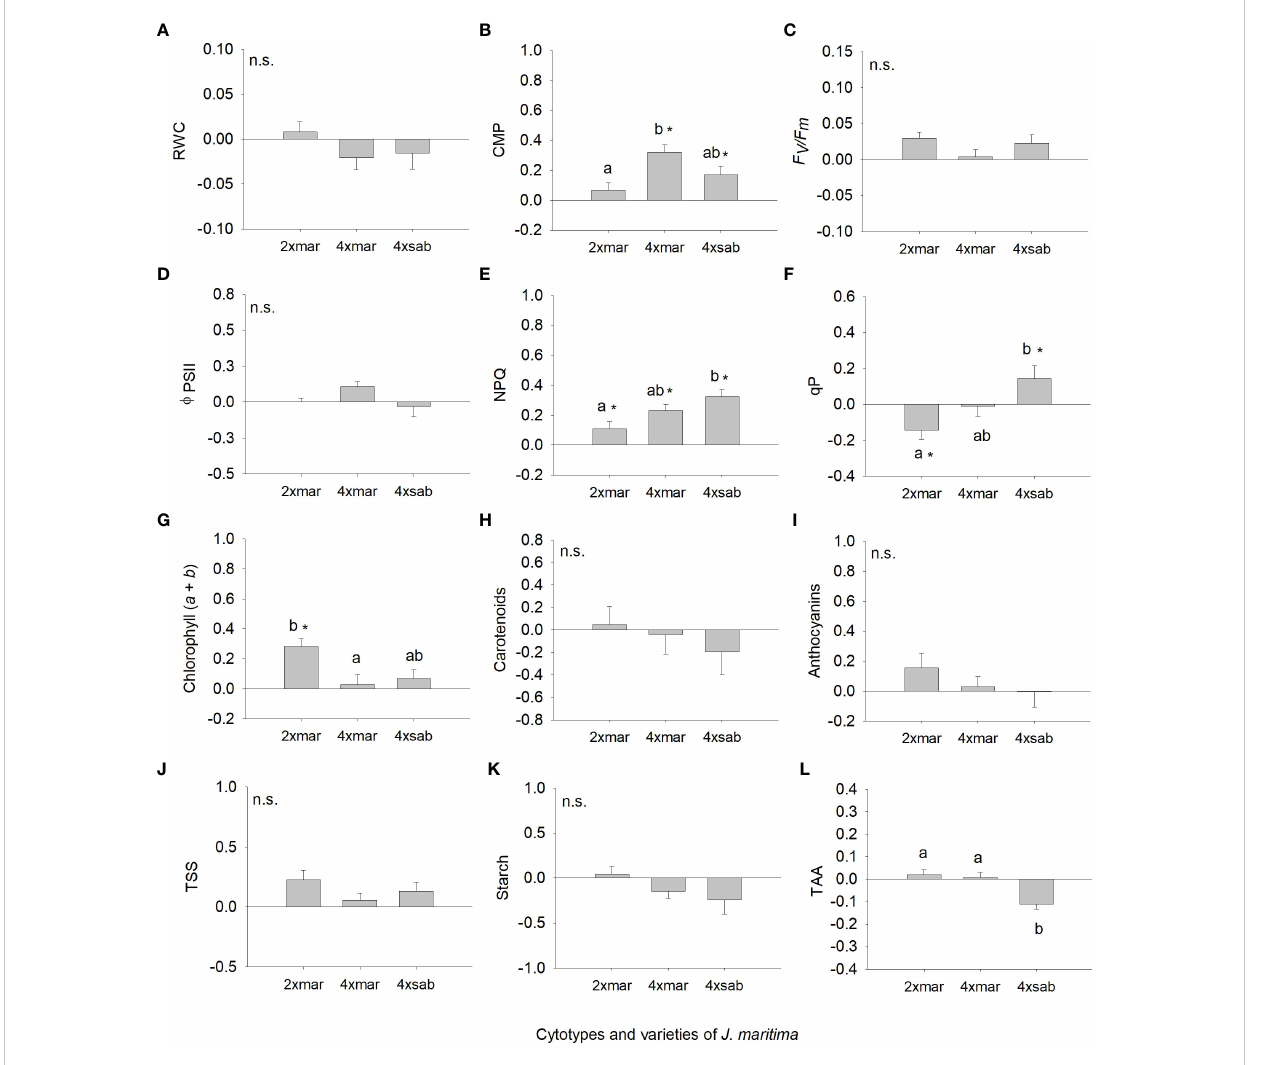
FIGURE 6 Response ratio (mean ± SE) for relative water content (A) , cell membrane permeability (B) , maximum quantum ef fi ciency of photosystem II (C) , effective quantum ef fi ciency of PSII (D) , non-photochemical quenching (E) , photochemical quenching (F) , chlorophyll ( a+b ) (G) , carotenoid content (H) , anthocyanin ’ s content (I) , total soluble sugars (J) , starch content (K) and total antioxidant capacity (L) of populations of diploid and tetraploid Jasione maritima var maritima and tetraploid Jasione maritima var sabularia. Signi fi cant differences at P < 0.05 among cytotypes are indicated by different letters. The presence of * indicates that the response ratio differed signi fi cantly from zero. n.s. indicates the absence of signi fi cant